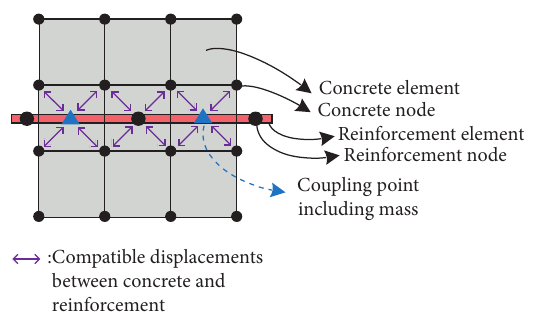
Figure 3: Concept of the CBIS model using coupling points in- cluding